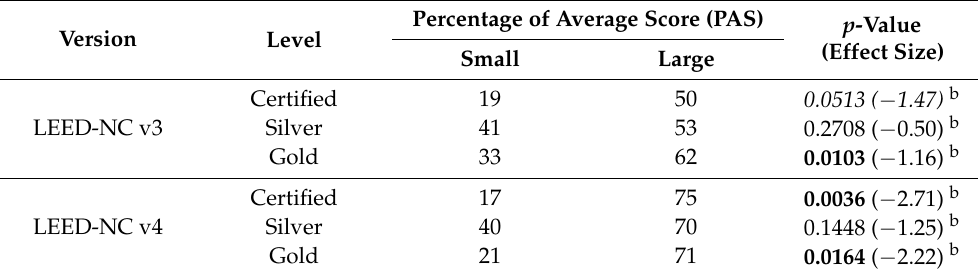
Table 9. LEED-NC v3/v4 office-type projects, enhanced refrigerant management credit.